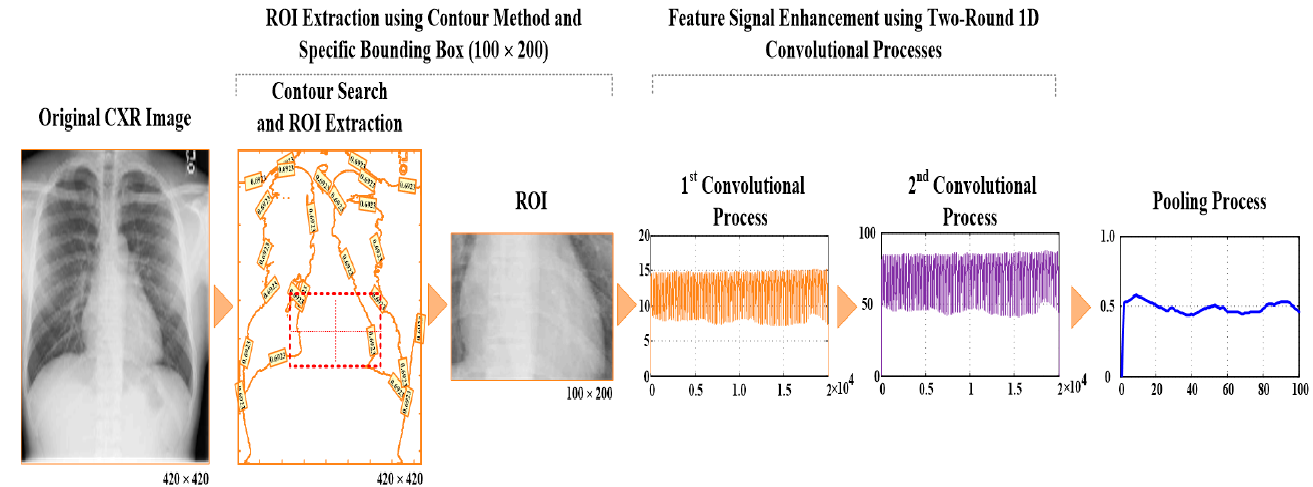
Figure 6. Flowchart of PA CXR image feature signal enhancement and extraction for cardiomegaly level screening.